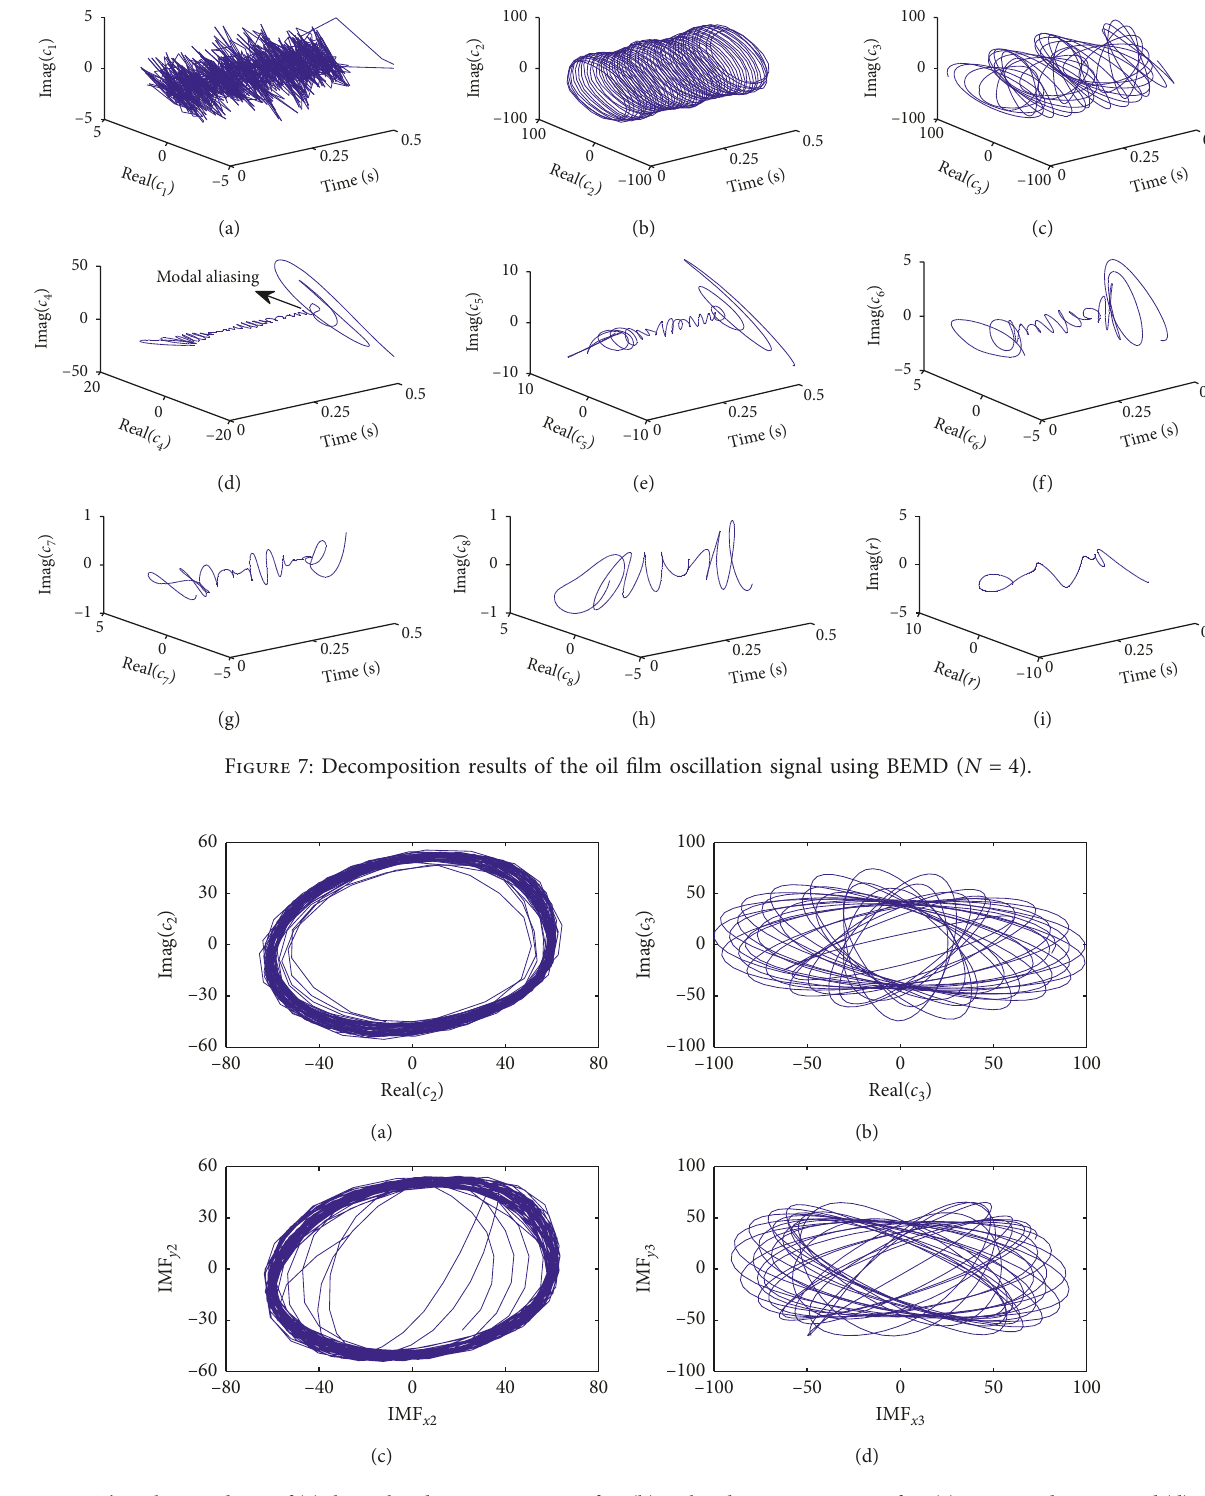
Figure 8: The orbits made up of (a) the real and imaginary parts of c and IMF y3